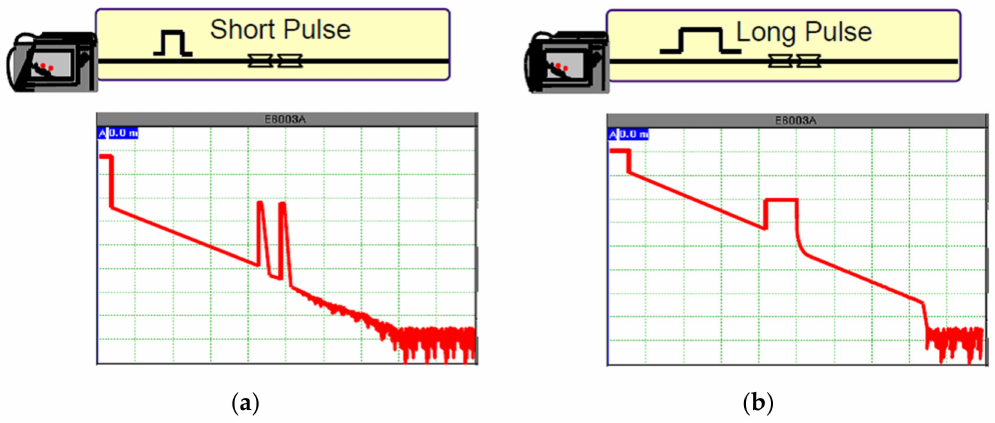
Figure 4. OTDR trace. ( a ) with a short pulse for better event resolution; ( b ) with a longer pulse for a longer